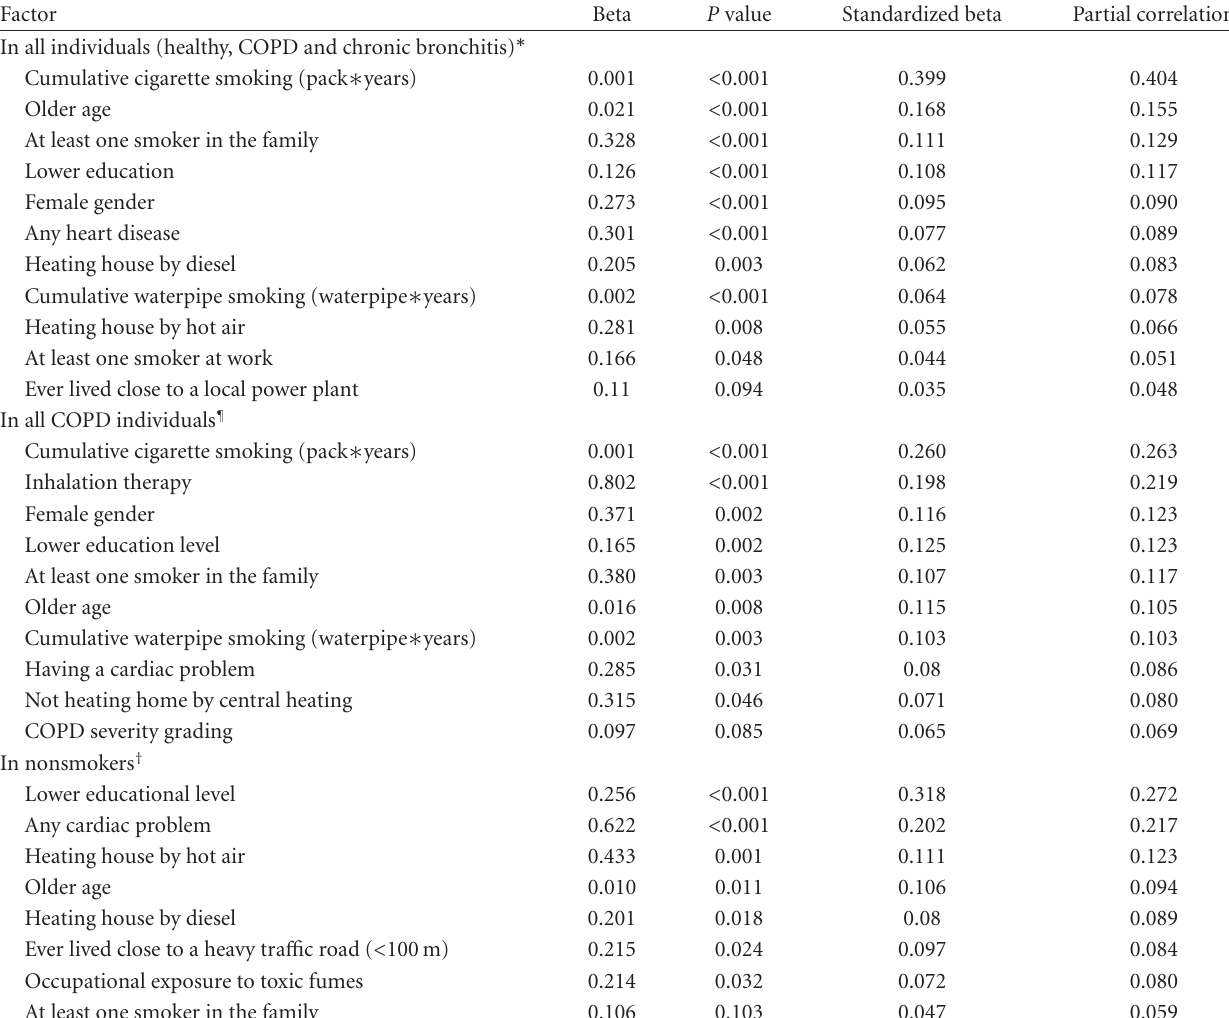
Table 6: Predictors of lower respiratory quality of life